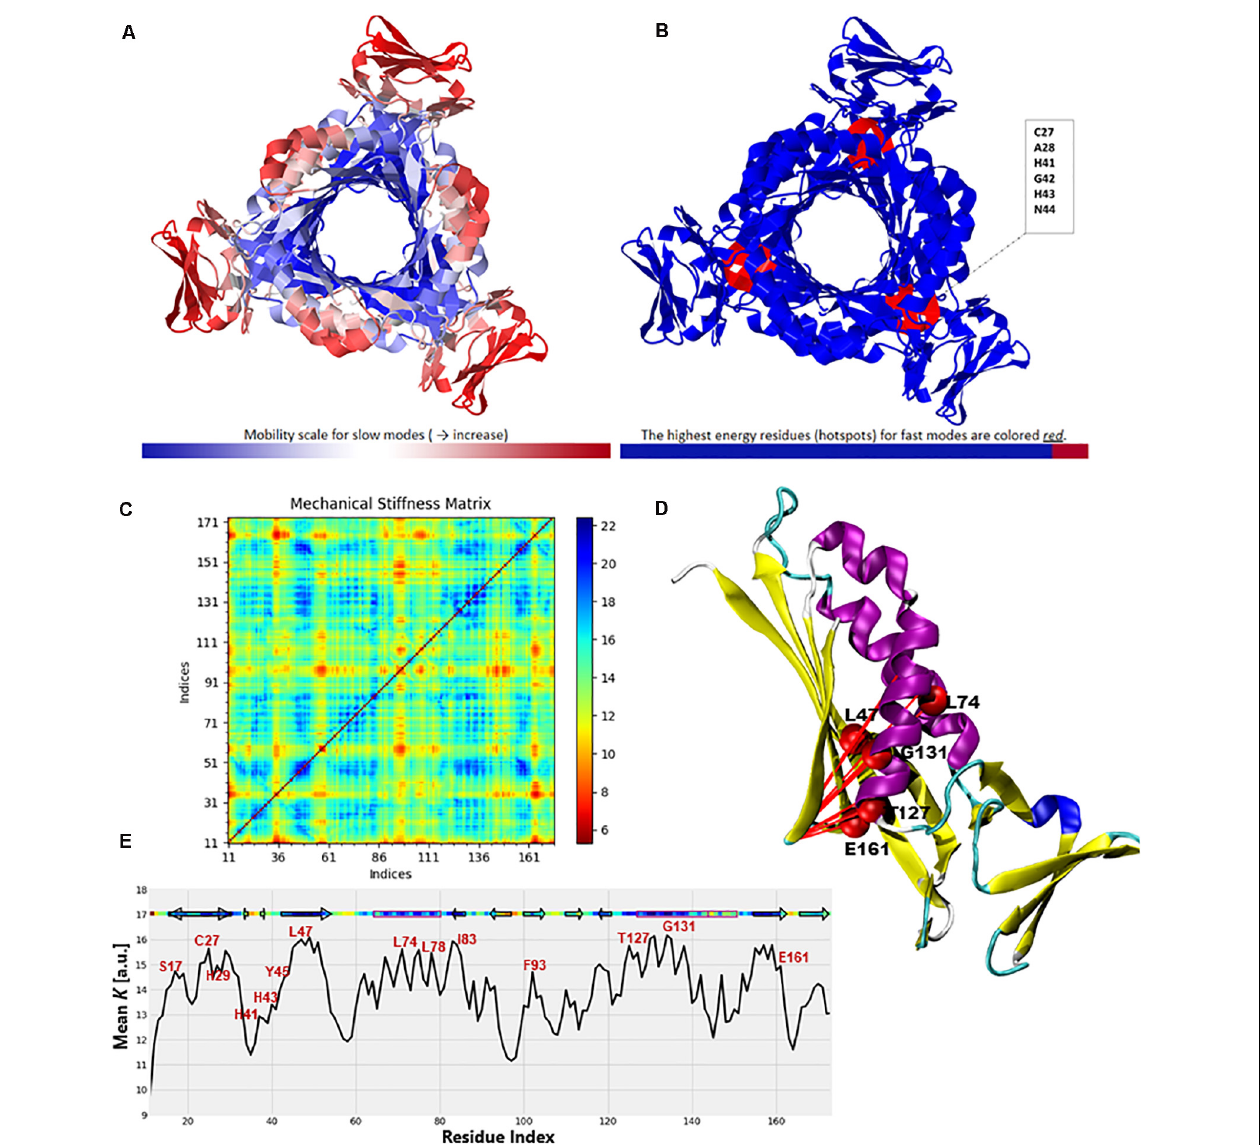
FIGURE 12 | Color-coded representation of the PTPS structure based on the mobility of the residues within the (A) Low-frequency and (B) High-frequency GNM modes. The color scale varies from blue as the most rigid to red as most mobile sites. The figures were obtained from the DynOmics portal (Li et al., 2017). (C) A mechanical resistance matrix obtained by calculating the effective force constant in response to uniaxial extensional forces exerted at each pair of residues. The scale varies from blue as residue pairs of the strongest interaction/rigid to red residue pairs of the weakest interaction/flexible. (D) A cartoon representation of a single chain of P. falciparum PTPS with the residues of strongest interaction mapped onto the structure and shown as red spheres. (E) The mean value of the effective spring constant over all pairs for each residue, with the secondary structures shown along the upper abscissa. The color bar shows strong regions/rigid in blue and weak regions/mobile in red. The figures were generated using the Matplotlib library and VMD.